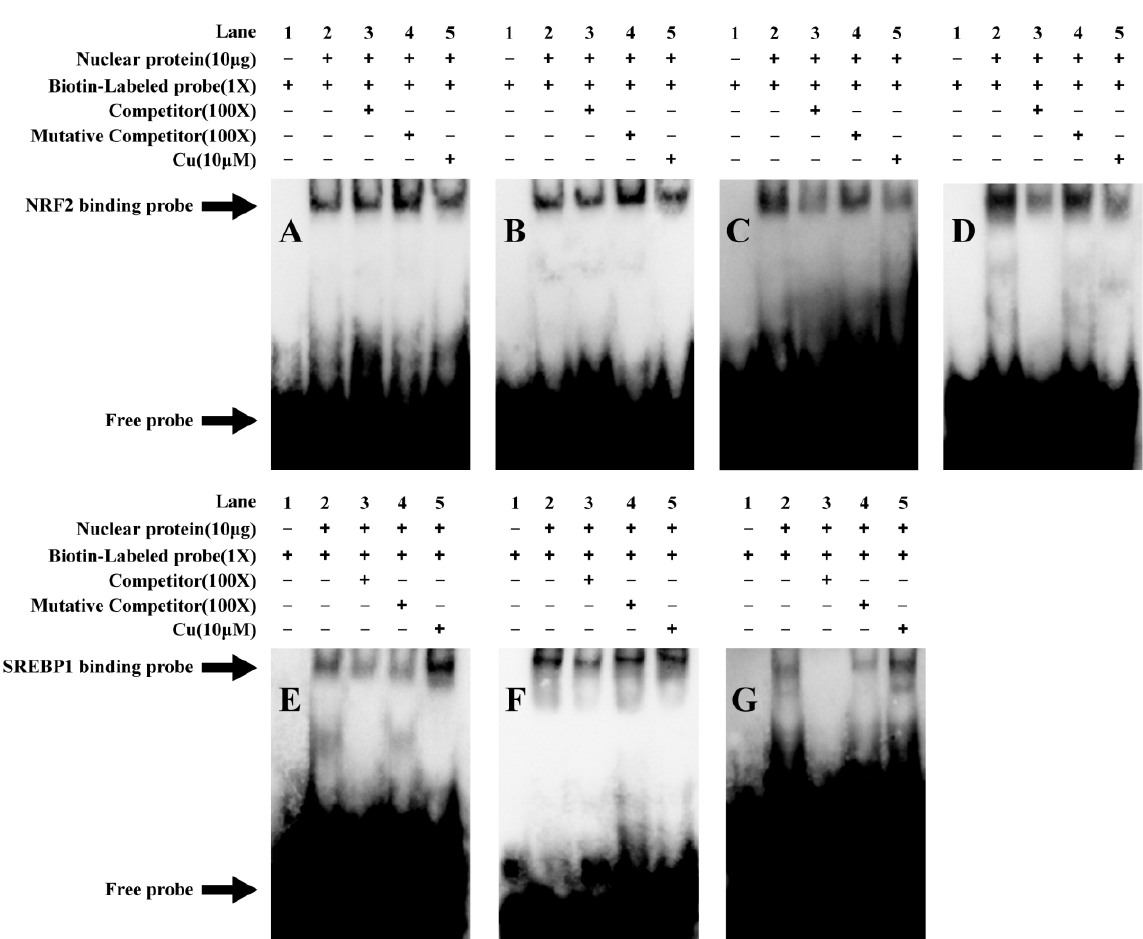
Figure 4. EMSA of predicted NRF2 and SREBP1 binding sequences on yellow catfish the ctr1 , ctr2 and atox1 promoters. ( A ) NRF2 binding sequence sited between − 820 bp and − 830 bp of the ctr1 promoter; ( B ) NRF2 binding sequence sited between − 1050 bp and − 1059 bp of the ctr1 promoter; ( C ) NRF2 binding sequence sited between − 326 bp and − 334 bp of the atox1 promoter; ( D ) NRF2